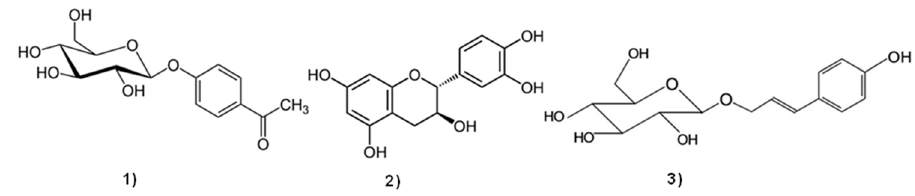
Scheme 1. Structures of major aromatic components in Salix Karin bark water extract: ( 1 ) picein, ( 2 ) (+)-catechin, and ( 3 ) triandrin.